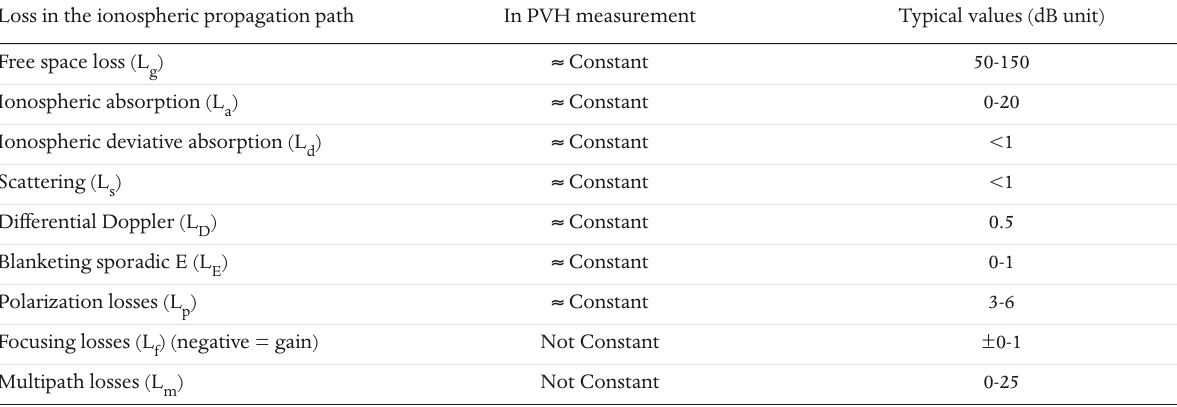
Table 1. Loss contributions in the PVH ionospheric propagation